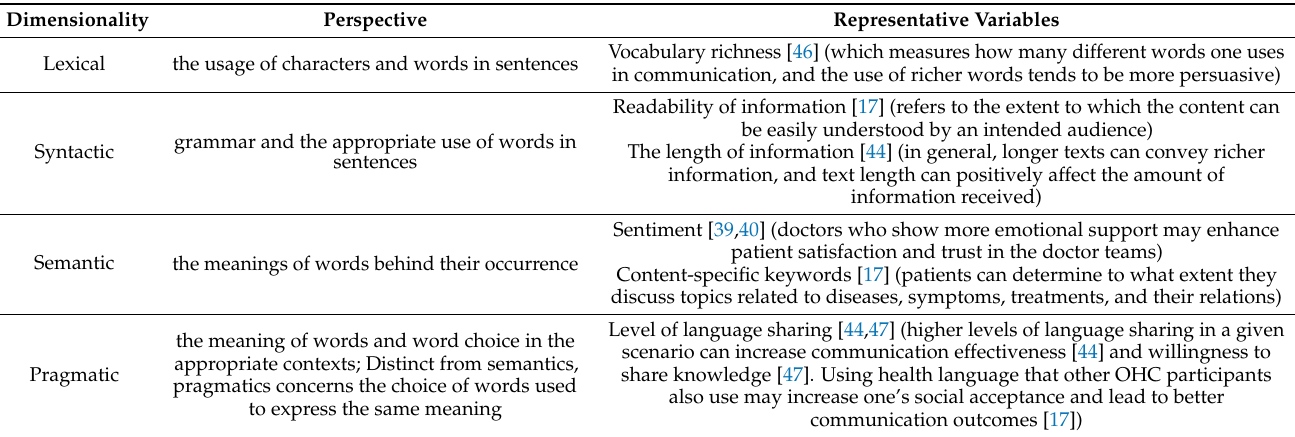
Table 3. Language style dimensions and